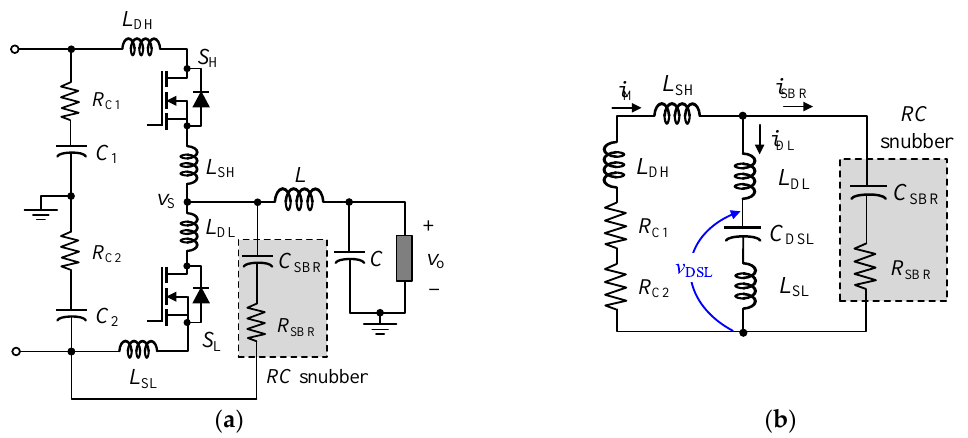
Figure 7. ( a ) half-bridge dc-ac converter with RC snubber ( b ) Equivalent circuit using high-frequency assumption.